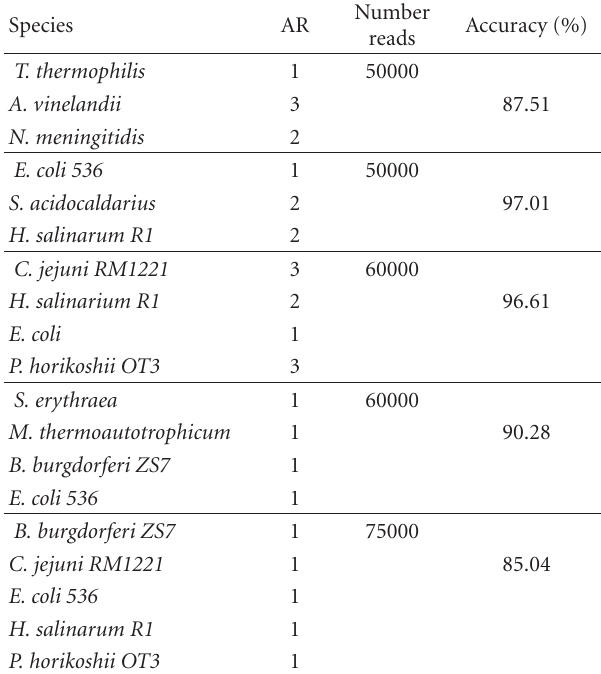
Table 1: Performance of Gaussian mixture model (without word grouping) on datasets containing more than 2 species, at various abundances on reads of length 500 bp. AR stands for abundance